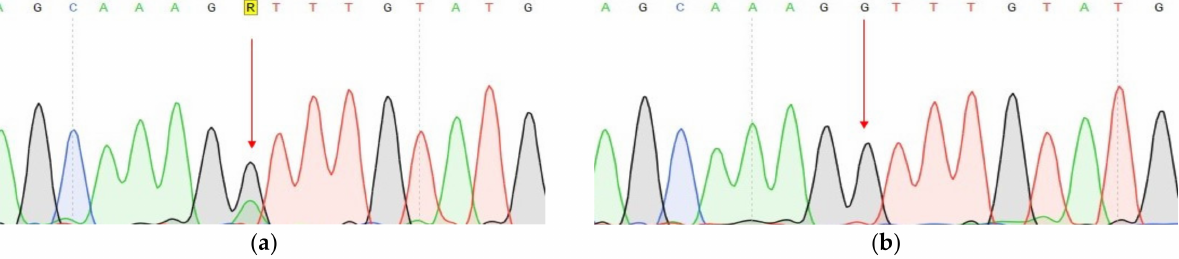
Figure 3. Fragments of the DNA sequence with the c.1320+1G>A variant in the CDH1 ( a ) DNA sample with a change, isolated from the tumor tissue of a patient 8 GC; ( b ) Control DNA sample without change.